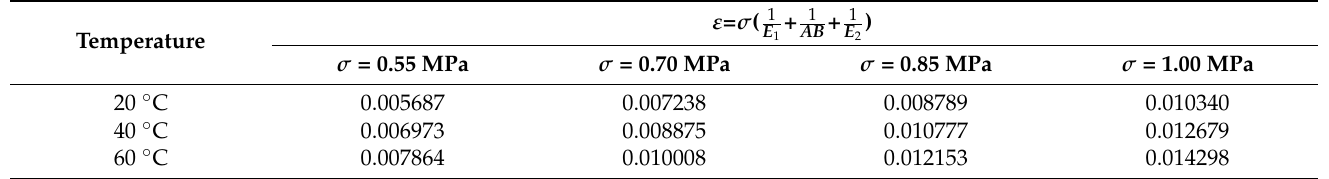
Table 8. Prediction of limit strain by the modified Burgos